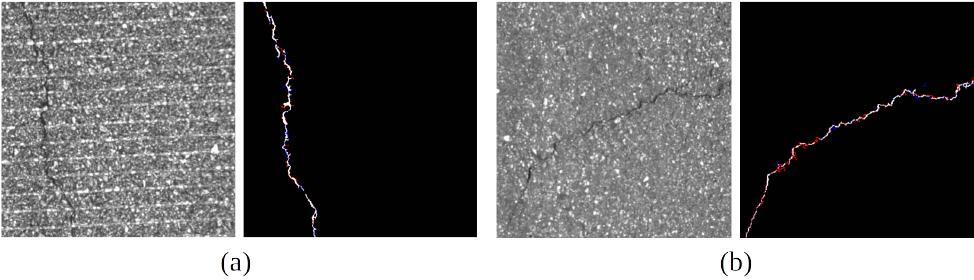
Figure 3. Comparison with GT and our prediction at different accuracies. White pixels present intersection between GT and our prediction. Red pixels are GT , and blue pixels are crack segmentation results, respectively. ( a ) Dice is 0.83, ( b ) dice is 0.58.